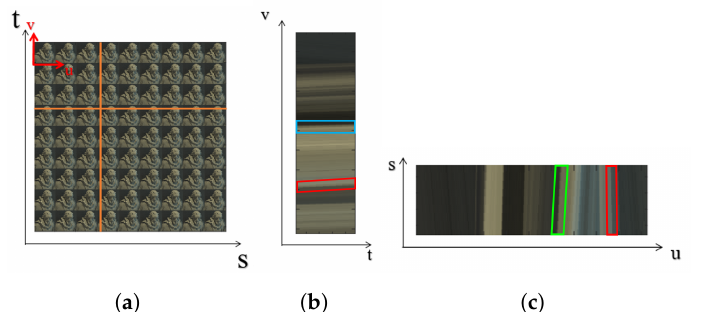
Figure 1. ( a ) The sub-aperture image view; ( b ) the EPI for the vertical line represented in ( a ); ( c ) the EPI for the horizontal line represented in ( a